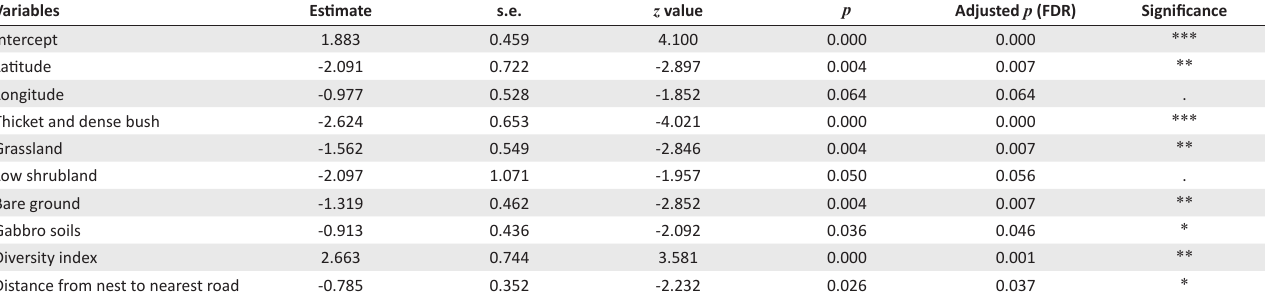
TABLE 3: Parameter estimates, standard errors, z values, p -values and adjusted p -values (using False Discovery Rate) for variables in the best LAND model for Southern Ground-hornbill nesting success (with the lowest Akaike information criteria). Variables